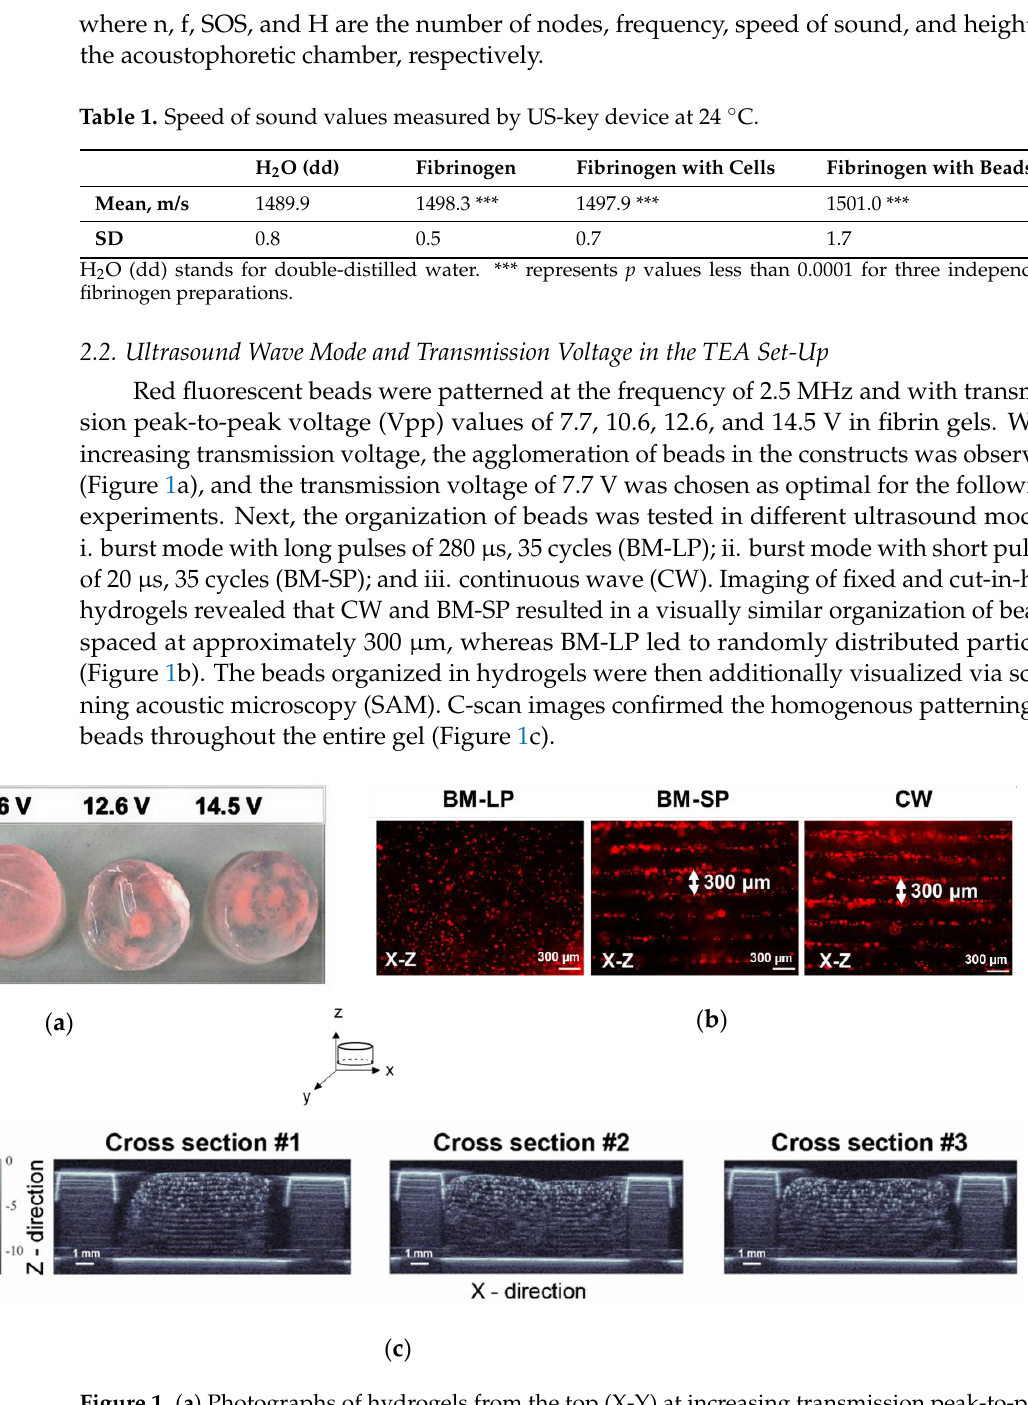
Table 1. Speed of sound values measured by US-key device at 24 ◦ C.